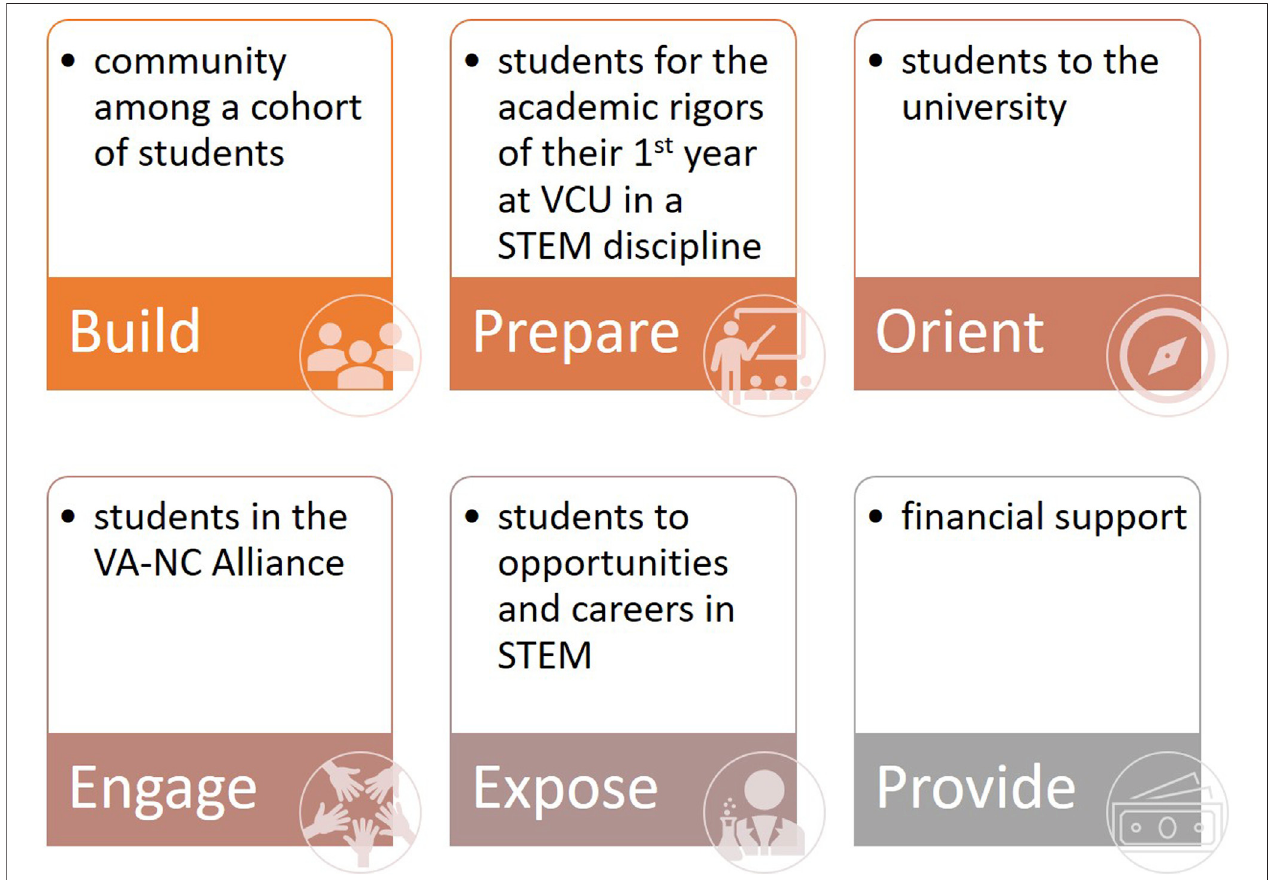
FIGURE 1 | VCU-LSAMP